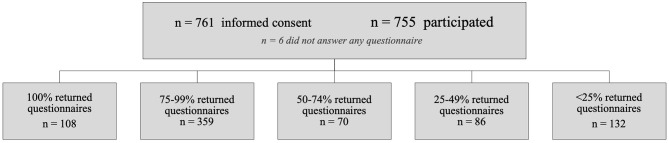
Overview of the reported childweeks obtained in the cohort. Questionnaires on 55,524 childweeks were obtained out of the potential 78,520 (70.7%). Parents sometimes missed reporting one or more childweeks (n = 6,773 weeks); in addition, some parents entirely stopped participation before the 2 years had been completed (n = 16,223 weeks missing).